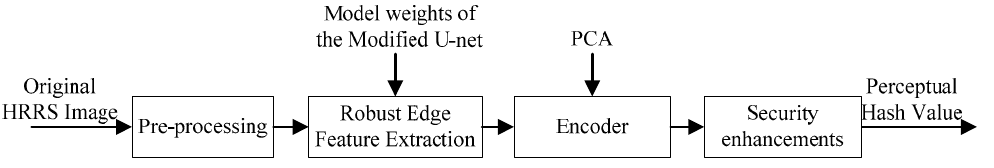
Figure 6. Framework of the perceptual hash value generation.